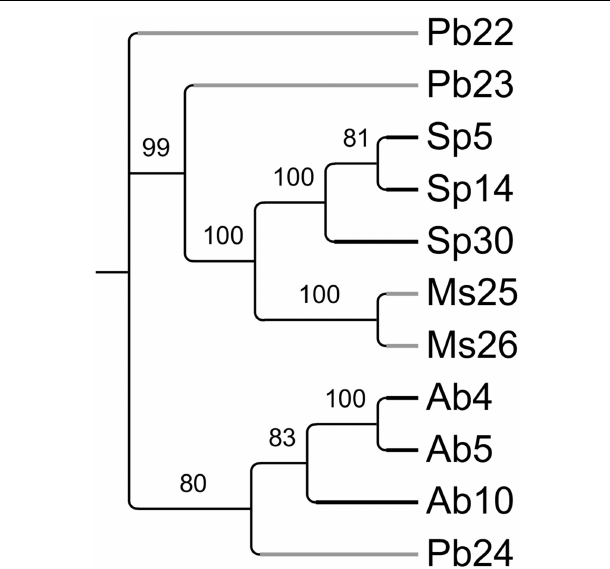
FIGURE 3 | Most parsimonious tree reflecting similarity in endophyte diversity between the sampled plants (PAUP, obtained from T-RFLP data matrix listed in Supplemental Table 1). Values above the branches represent parsimony jackknife support values ≥ 50%. Physaria bellii 22 was used to root the tree. Black branches represent hyperaccumulators and gray branches represent non-hyperaccumulators.